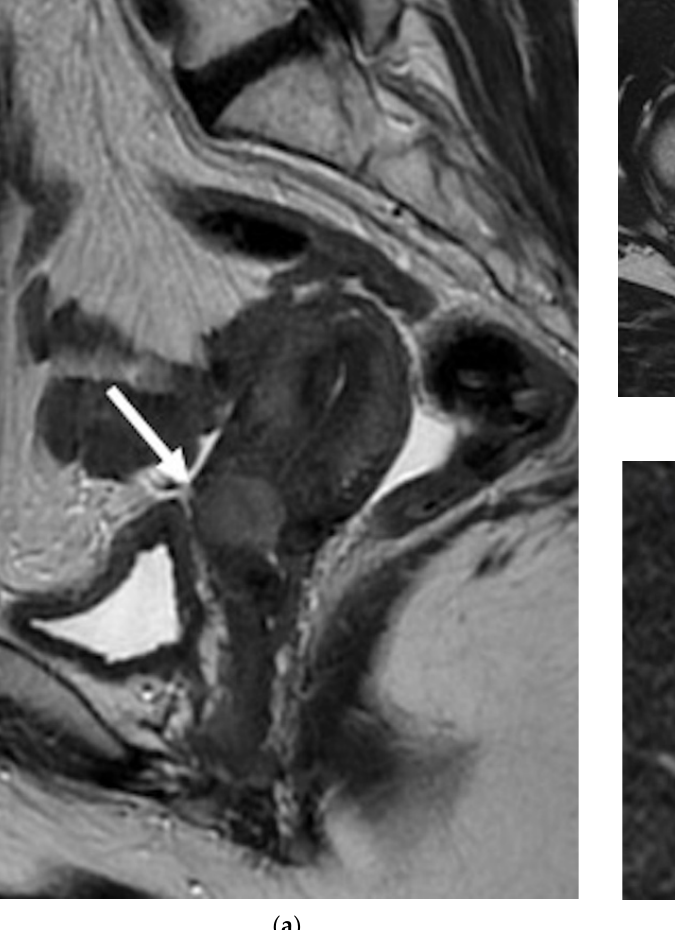
Figure 2. A 42-year-old patient with history of cervical cancer treated with chemoradiation therapy. ( a ) Sagittal and ( b ) axial FSE T2-weighted images show a nodular hyperintense lesion in the anterior aspect of the cervix, causing interruption of the hypointense cervical stroma, consistent with recurrence (arrows). ( c ) Axial diffusion-weighted image demonstrates restricted diffusion of the lesion (arrowhead).